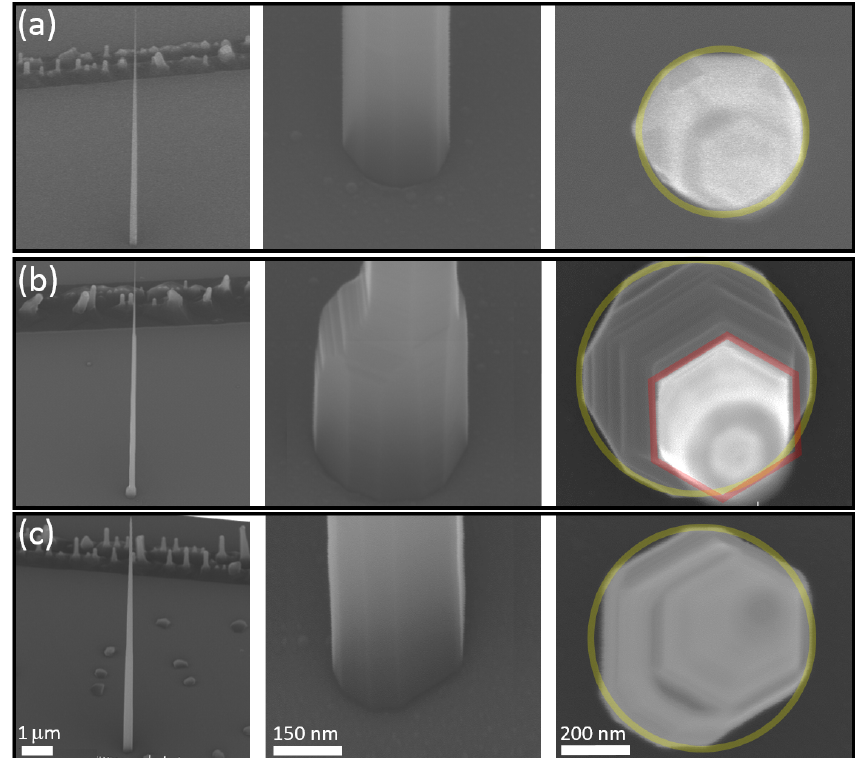
Figure 6. ( a ) SEM images of the full nanowire (left panel), the base (middle panel) and a top view (right panel) for growth on a mask prepared using a 20 s wet-etch. ( b ) Same as ( a ) for a mask prepared using a 24 s wet-etch. ( c ) Same as ( b ) with an additional t p = 64nm of cladding deposited. Yellow circles indicate the size of the oxide opening. Red hexagon in ( b ) shows the base of the uniformly tapered section of the